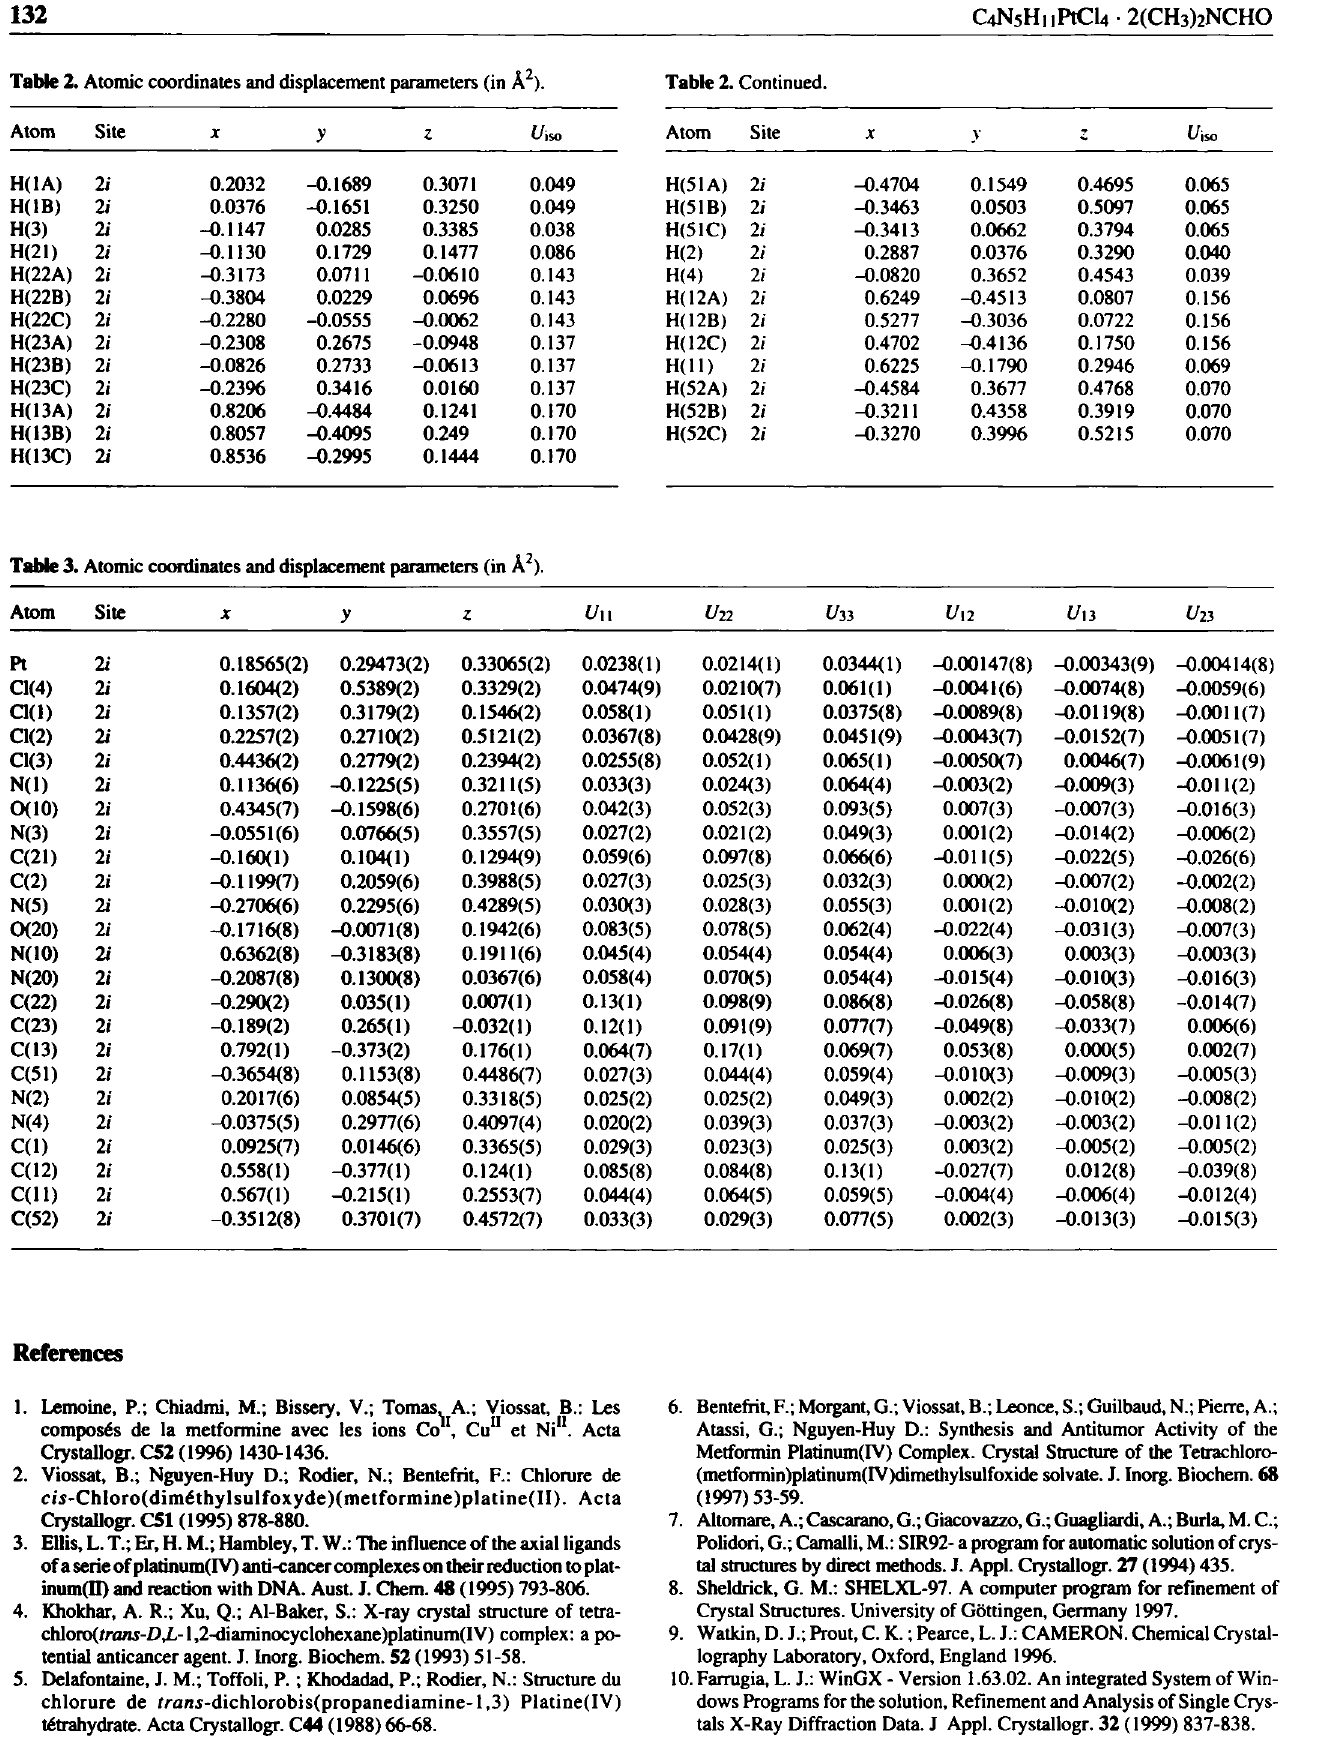
Table 2. Atomic coordinates and displacement parameters (in À 2 ).